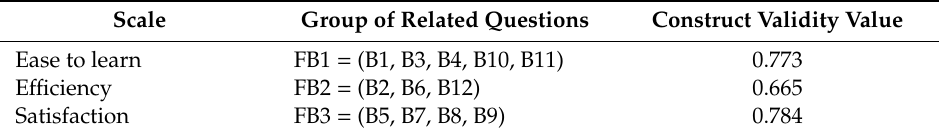
Table A11. Construct validity values of the three scales of the indicator of “system usability.”. Scale